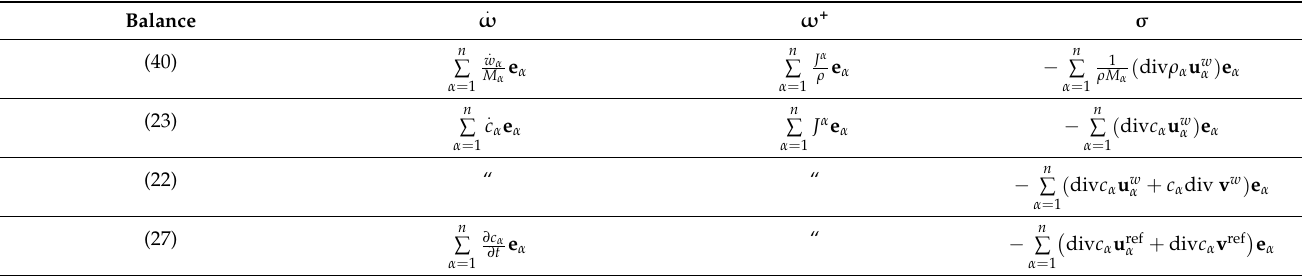
Table 1. Definitions of vectors to be used in addressing self-balanced diffusion in various balance